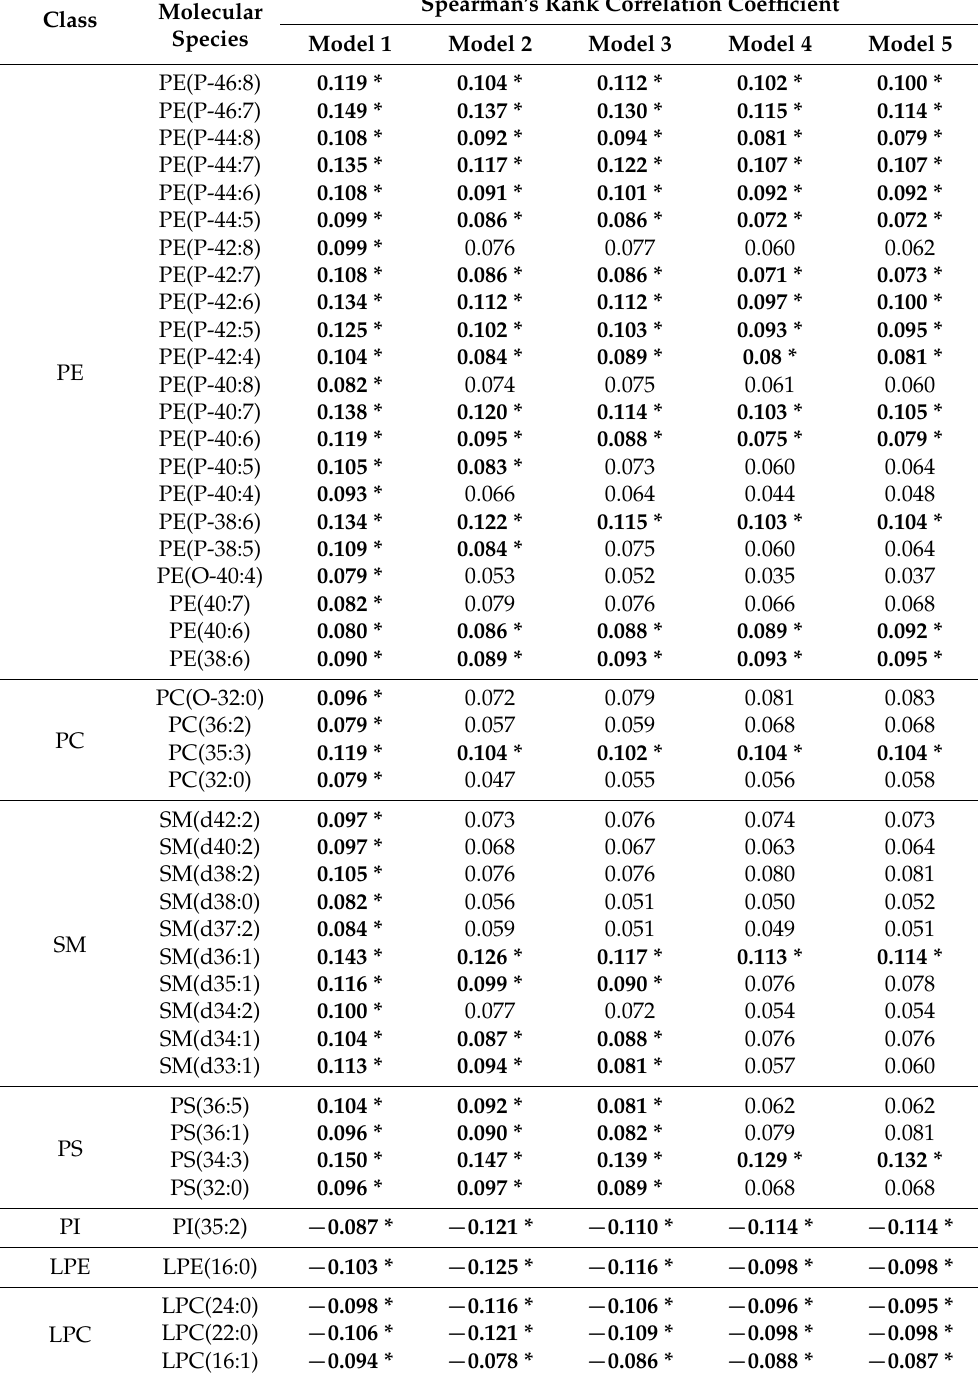
Table 5. Correlation coefficients of Individual phospholipid molecular species associated with MoCA score 1